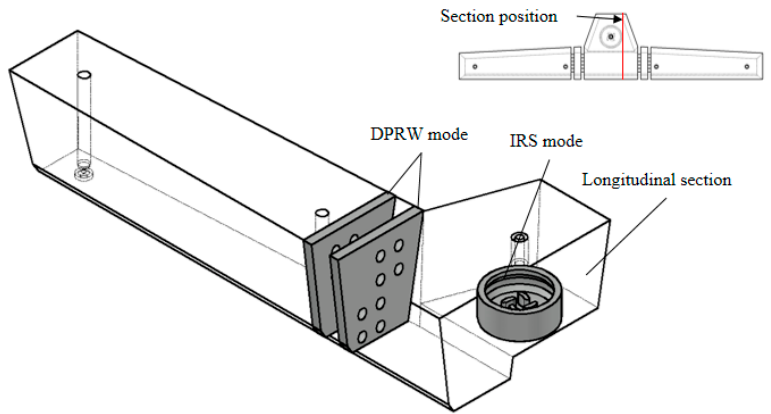
Figure 3. SCB structure location.